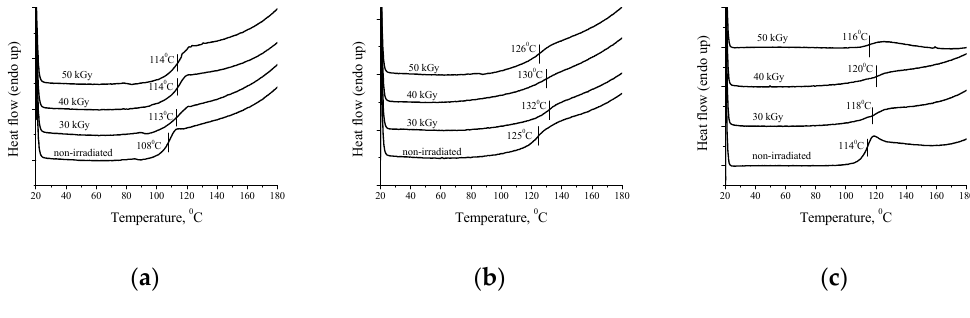
Figure 5. DSC curves for (a) PAA ; (b) PAH18 ; (c) PAH9 .